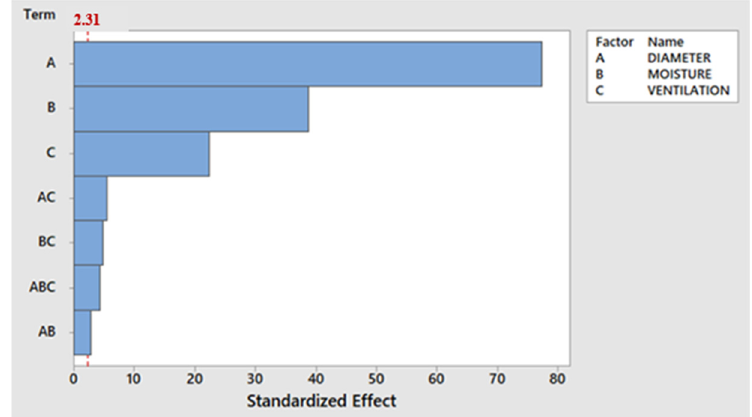
Figure 9. Pareto chart of the standardized effects.